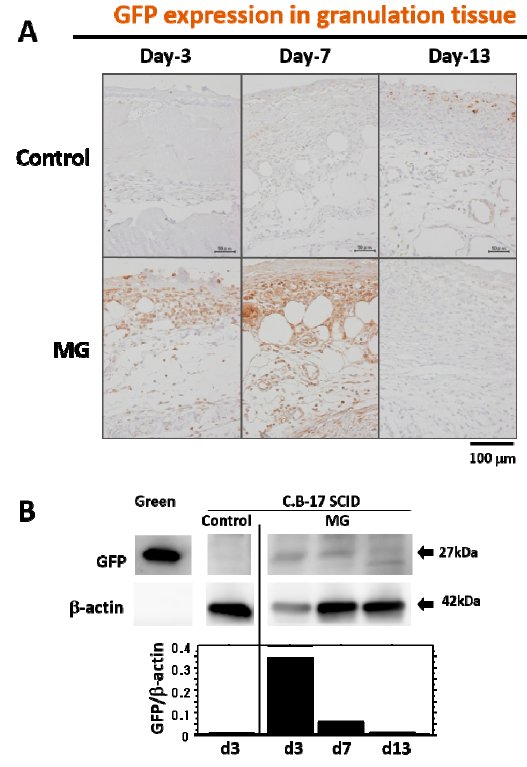
Figure 2. GFP expression in granulation tissue after wounding. ( A ) Presence of GFP in granulation tissue developed after wounding was immunohistochemically detected in immune-deficient SCID mice with micrograft of skin tissue solution from GFP-positive green mouse or saline alone (control) on Days 3, 7 and 13. Photographs are representative wounds in each group. Scale bars = 100 μ m; ( B ) Western blot analysis for GFP in granulation tissue was performed in SCID mice with micrograft of skin tissue solution from green mouse or saline alone (control) on Days 3, 7 and 13. Green mice were used as a positive control. Densitometry analysis of GFP and β -actin was also conducted; relative expression value of GFP is shown in the bar graph.